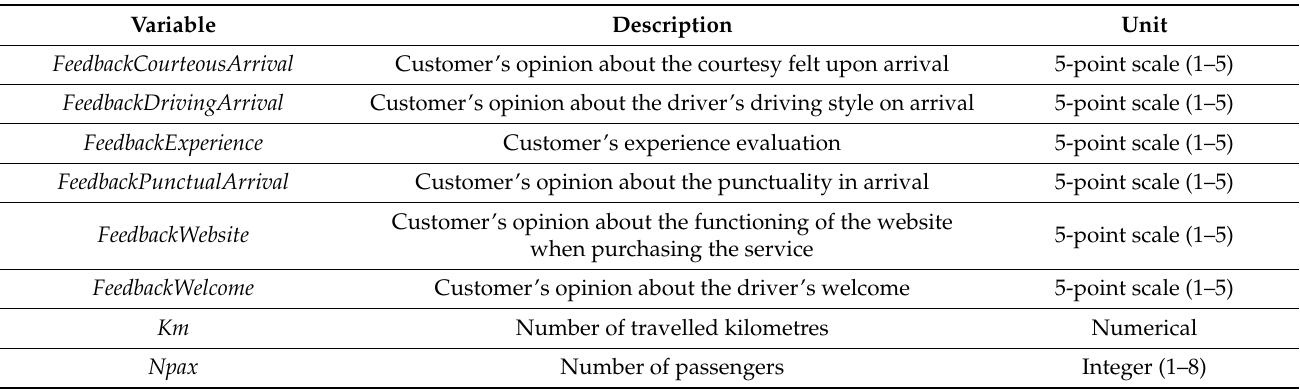
Table 1. Numeric variables considered in the study.